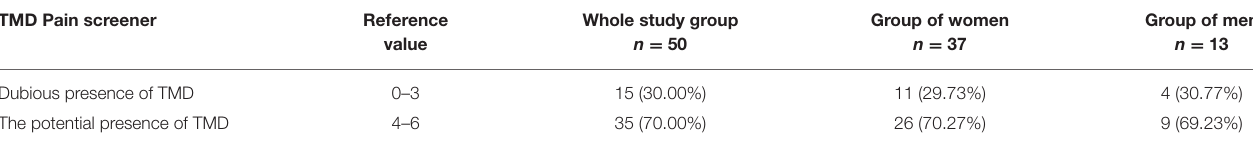
TABLE 1 | TMD-Pain Screener results (Axis I of DC/TMD) in the whole study group ( n = 50), group of women ( n = 37), and men ( n = 13). TMD Pain